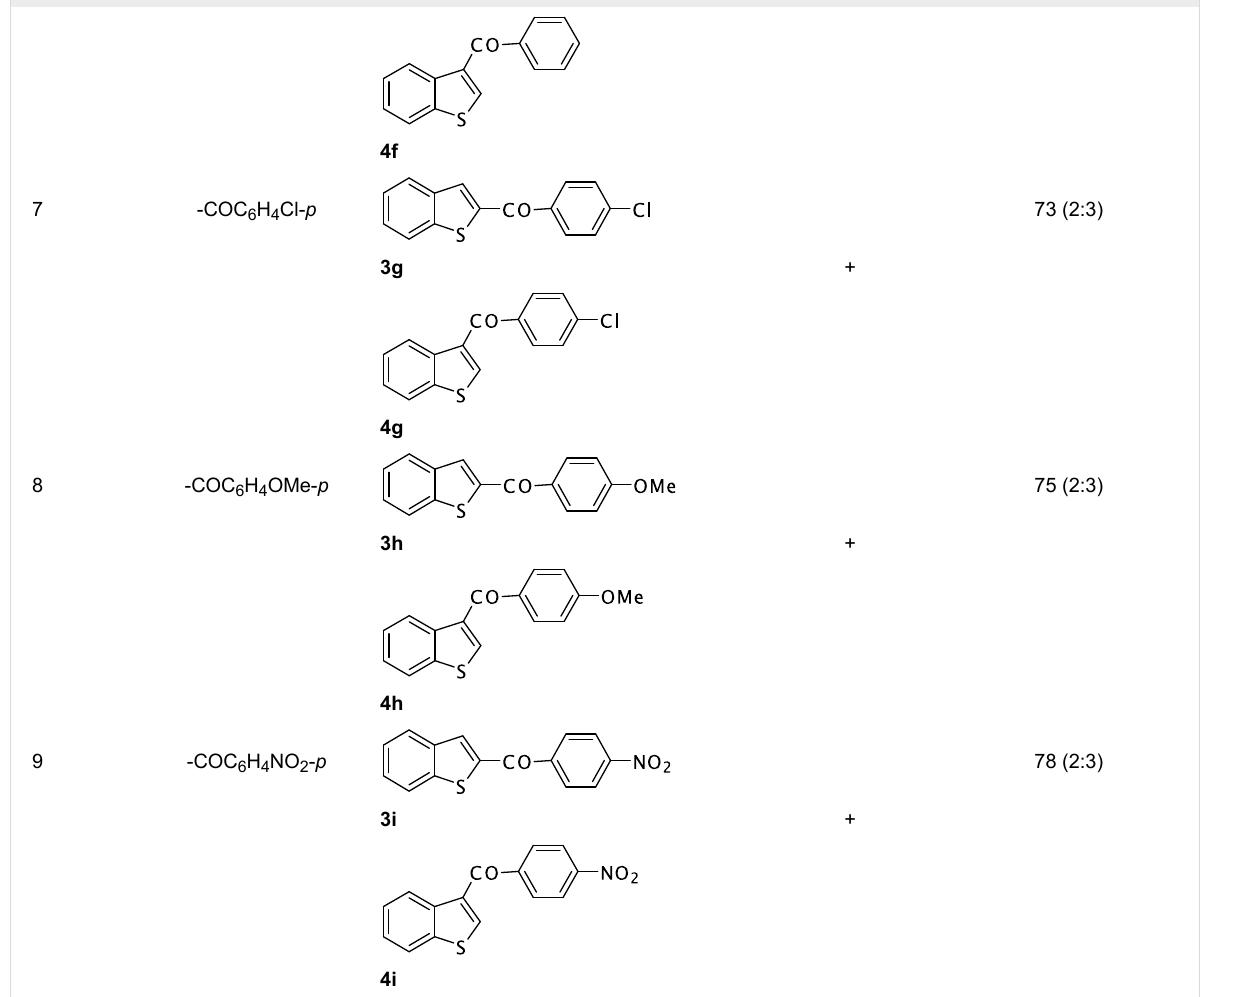
Table 1: Synthesis of acyl substituted benzothiophenes ( 3 & 4 ) via acylation of benzothiophene ( 1 ) with alkyl/aryl